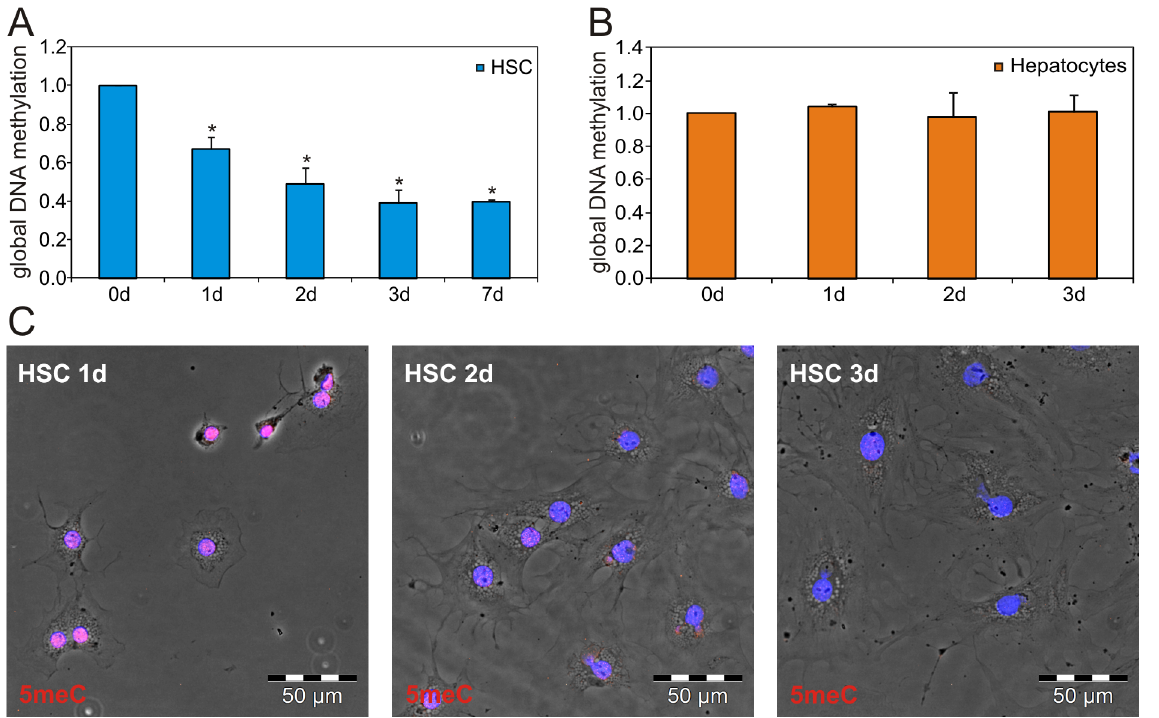
Fig 1. Global DNA demethylation during HSC activation. (A) Global DNA methylation determined by a 5meC ELISA showed a significant reduction to approximately 40% of the initial DNA methylation of freshly isolated HSC within 3 days of culture ( * p < 0.05 compared to HSC 0d, n = 4 independent experiments). (B) Global DNA methylation in hepatocytes was not altered during culture. (C) IF staining of 5meC (red) during early HSC activation. The nuclei were stained with DAPI (blue). All pictures were taken with the same exposure time and adjustments to enable direct comparison of the 5meC amount. Shown are representative images from one of 4 independent